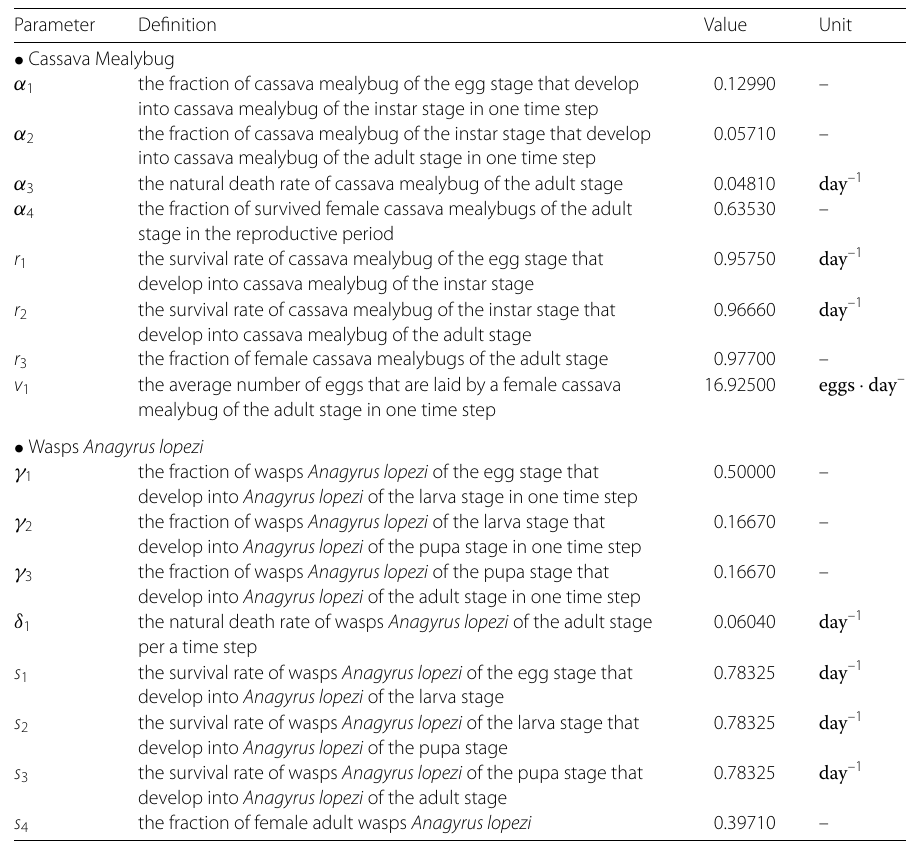
Table 1 Definition and calculated value of parameters in equations (1)–(7)